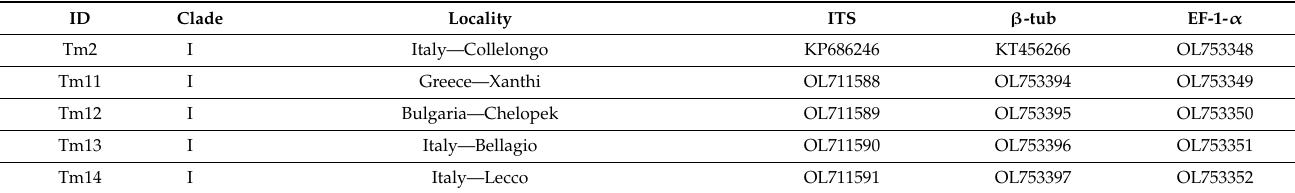
Table 1. Accession numbers and collection locality of the specimens analyzed in this